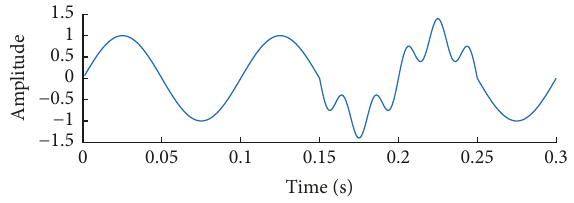
Figure 2: Vibration simulation synthetic signal.